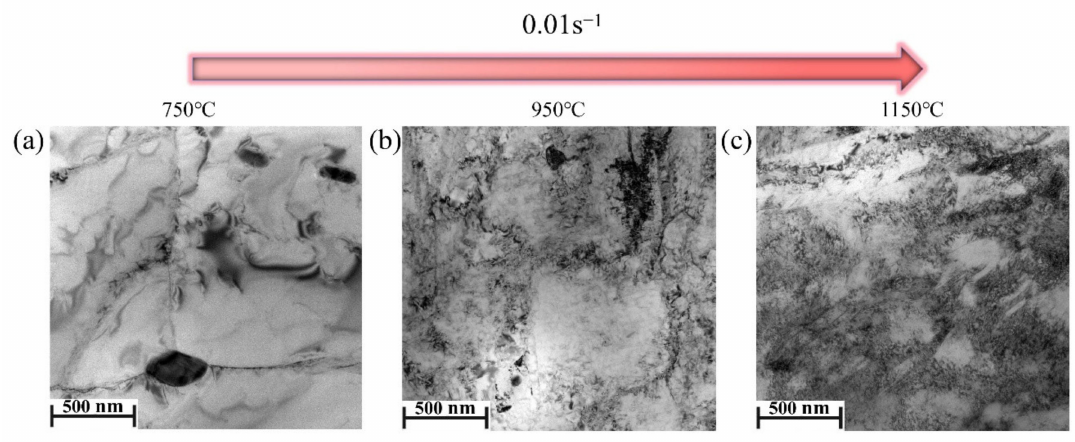
Figure 13. TEM images at different deformation temperatures: ( a ) 750 ◦ C, ( b ) 950 ◦ C, ( c ) 1150 ◦